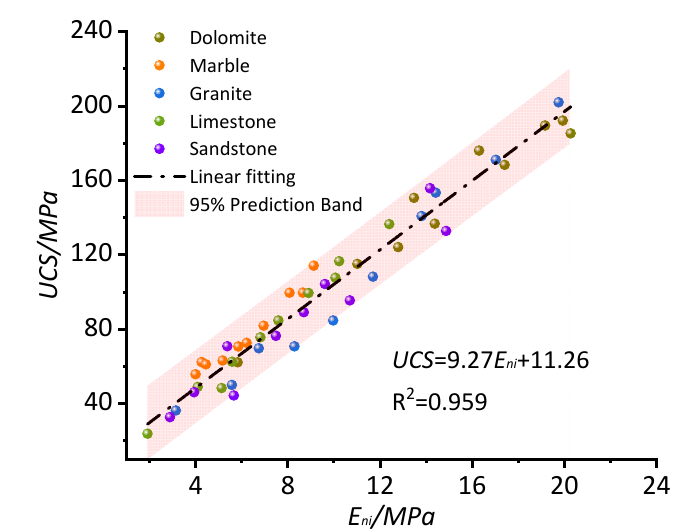
Figure 14. Comprehensive relationship between UCS and E ni for all the rock types.